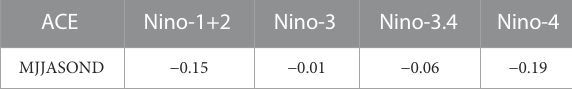
TABLE 1 Correlations of ACE during May-December with simultaneous Niño-1+2, Niño-3, Niño-3.4 and Niño-4 sea surface temperature